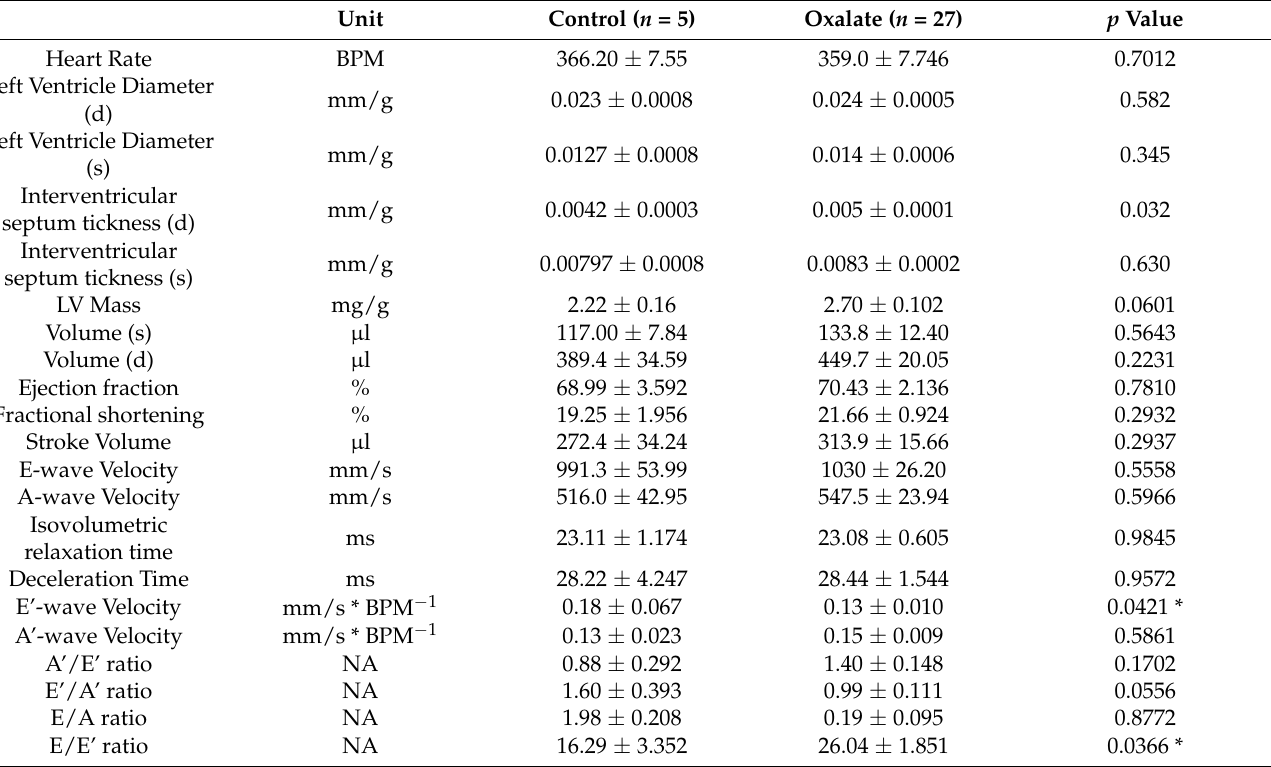
Table 2. Echocardiographic parameter analysis after 3 weeks of OXA diet (results are expressed as mean ± SD. Control n = 5, oxalate n =